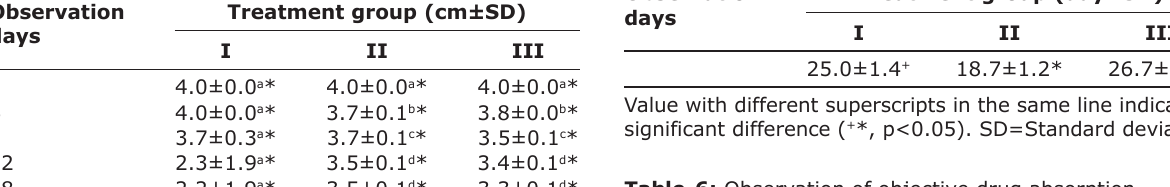
Table-6: Observation of objective drug absorption.